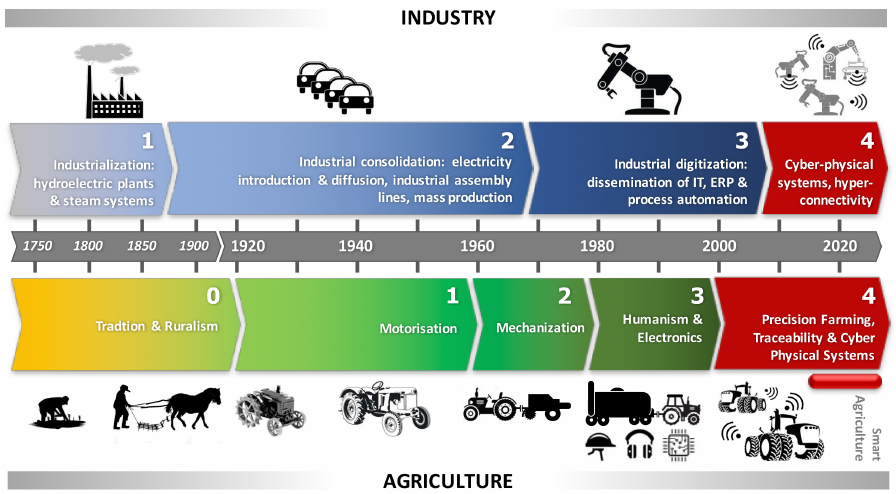
Figure 1. Comparison between the evolutionary technological phases of agriculture and